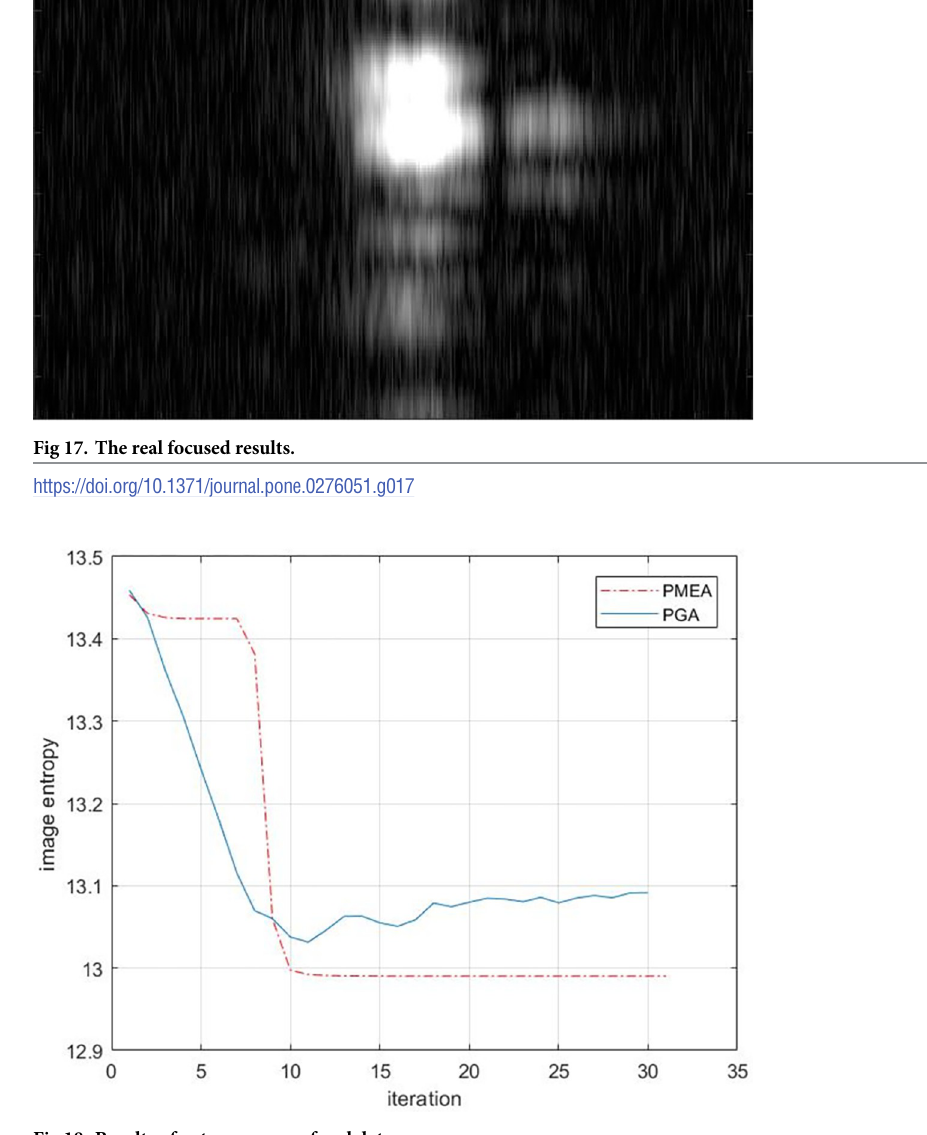
Fig 18. Results of entropy curve of real